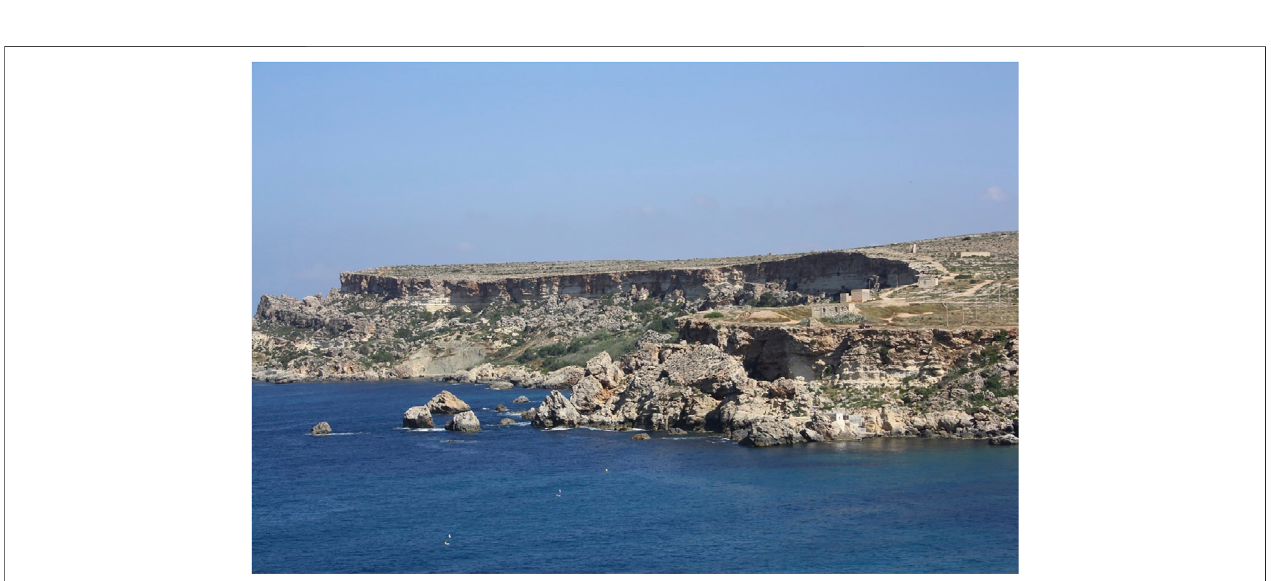
FIGURE 7 | Perspective view of landslides along the coast of northern Malta (photo by M. Soldati).